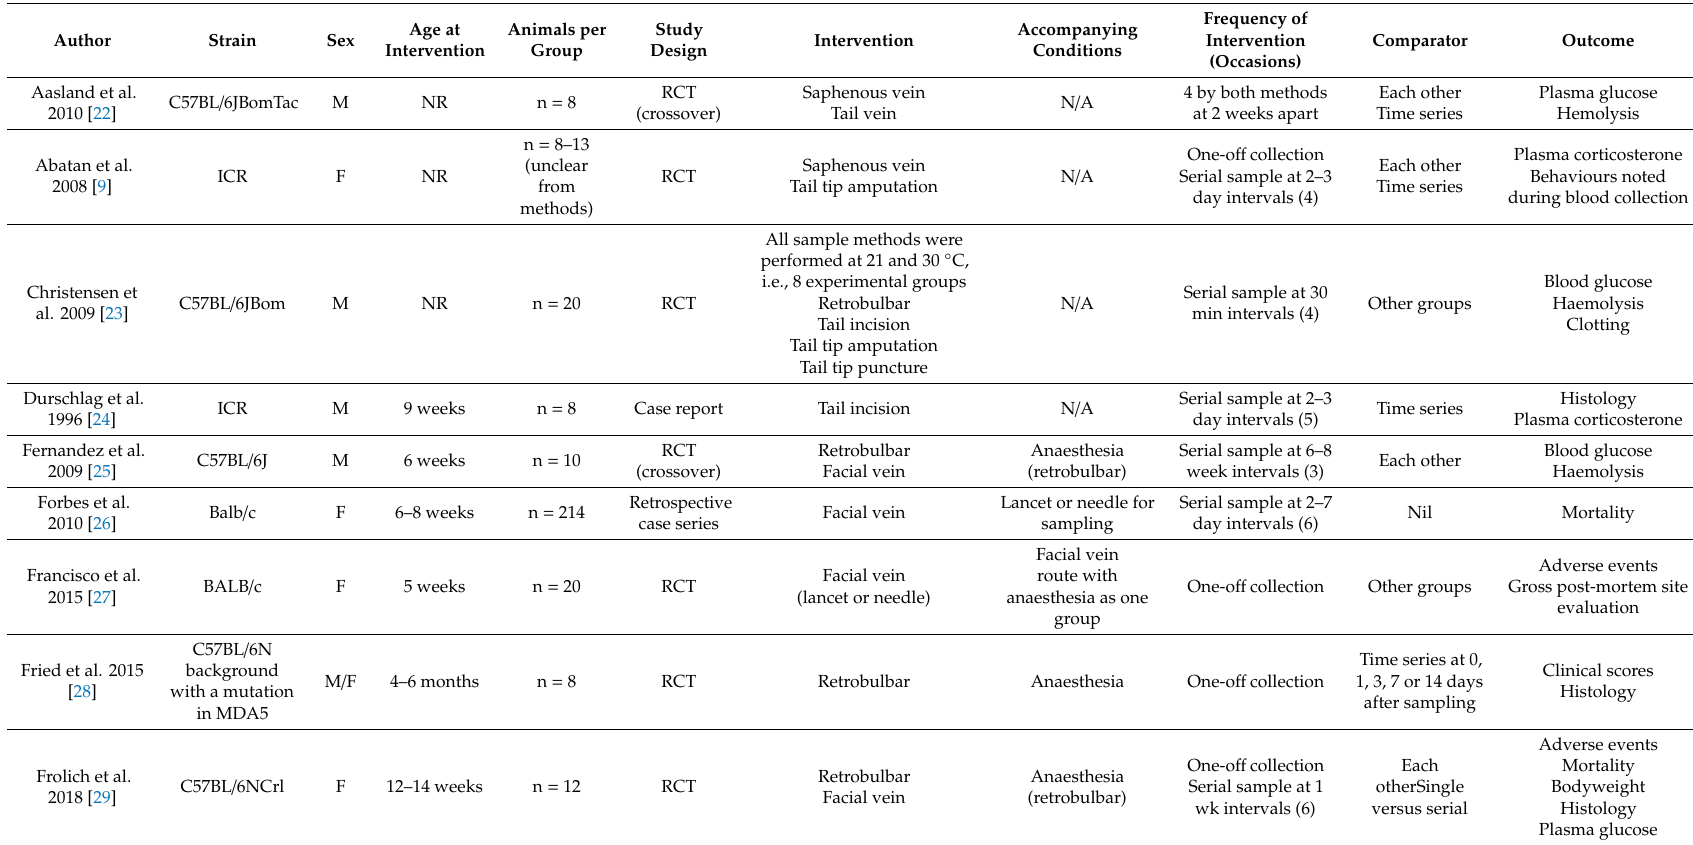
Table 2. Summary of included